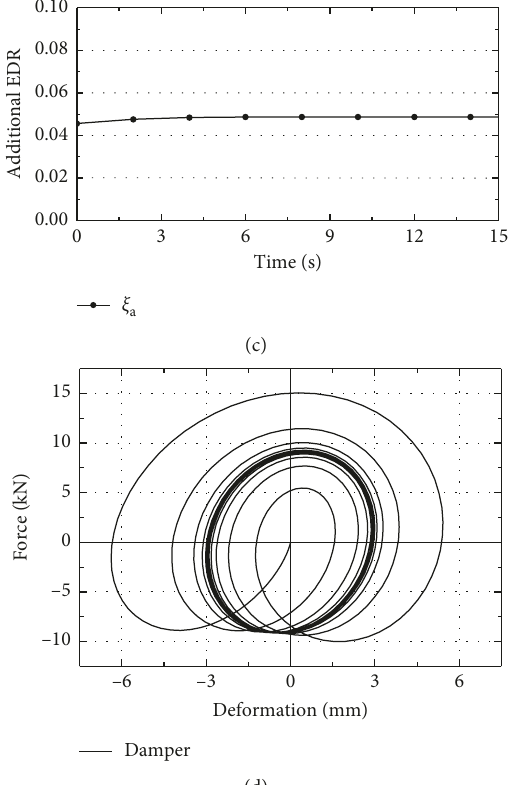
Figure 4: Time histories of additional EDRs obtained by the strain energy method under different sine waves of the SDOF system with the period equal to 1.0s and hysteresis curve of the viscous damper for the system under the sine wave with T � 0 . 5s. (a) Sine wave, T � 0 . 5s; (b) sine wave, T � 1 . 0s; (c) sine wave, T � 2 . 0 s; (d) hysteresis curve of damper.